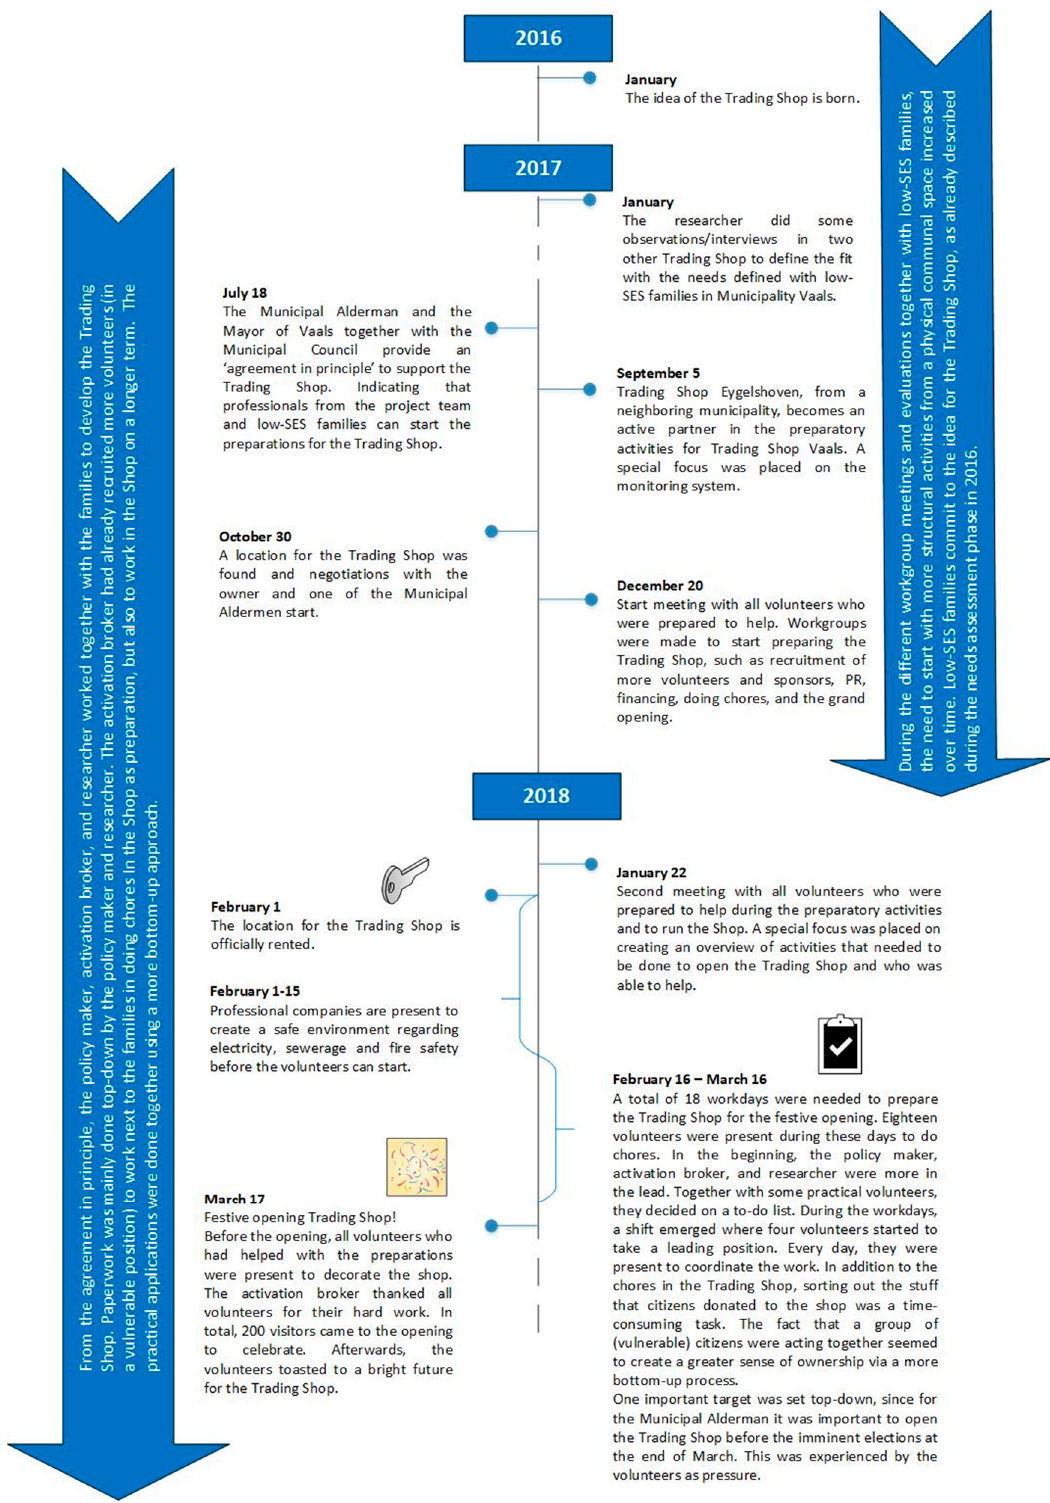
Figure 1. Timeline preparation process .